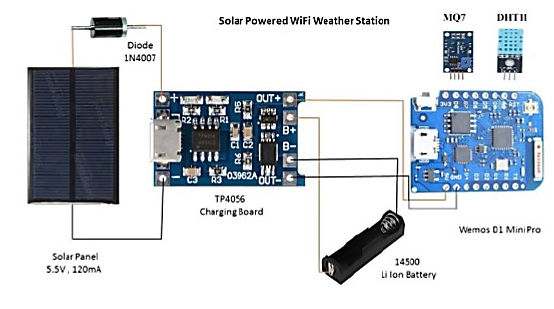
Figure.2. Connection